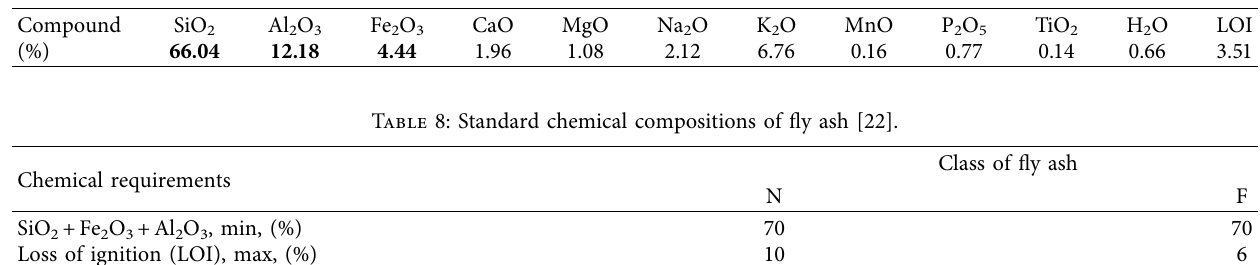
Table 7: Chemical compositions of BA.